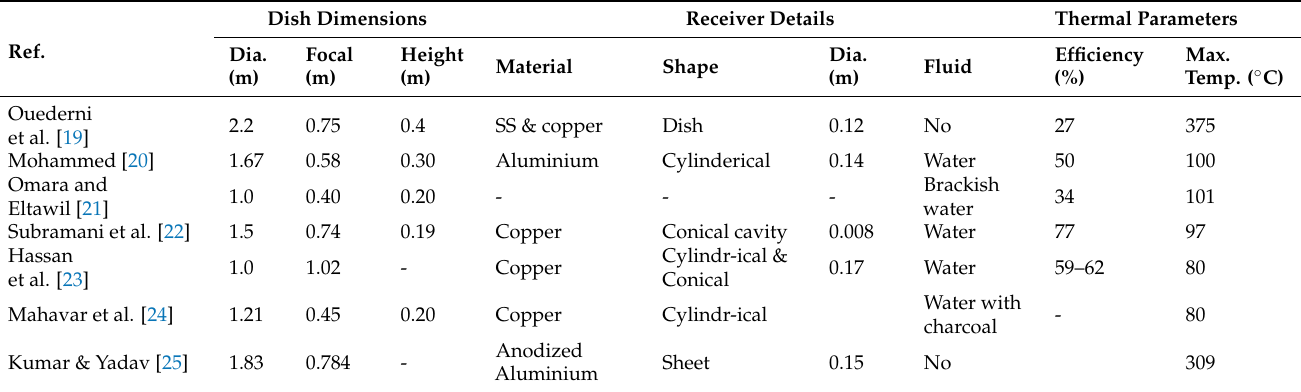
Table 2. Design parameters of small size solar